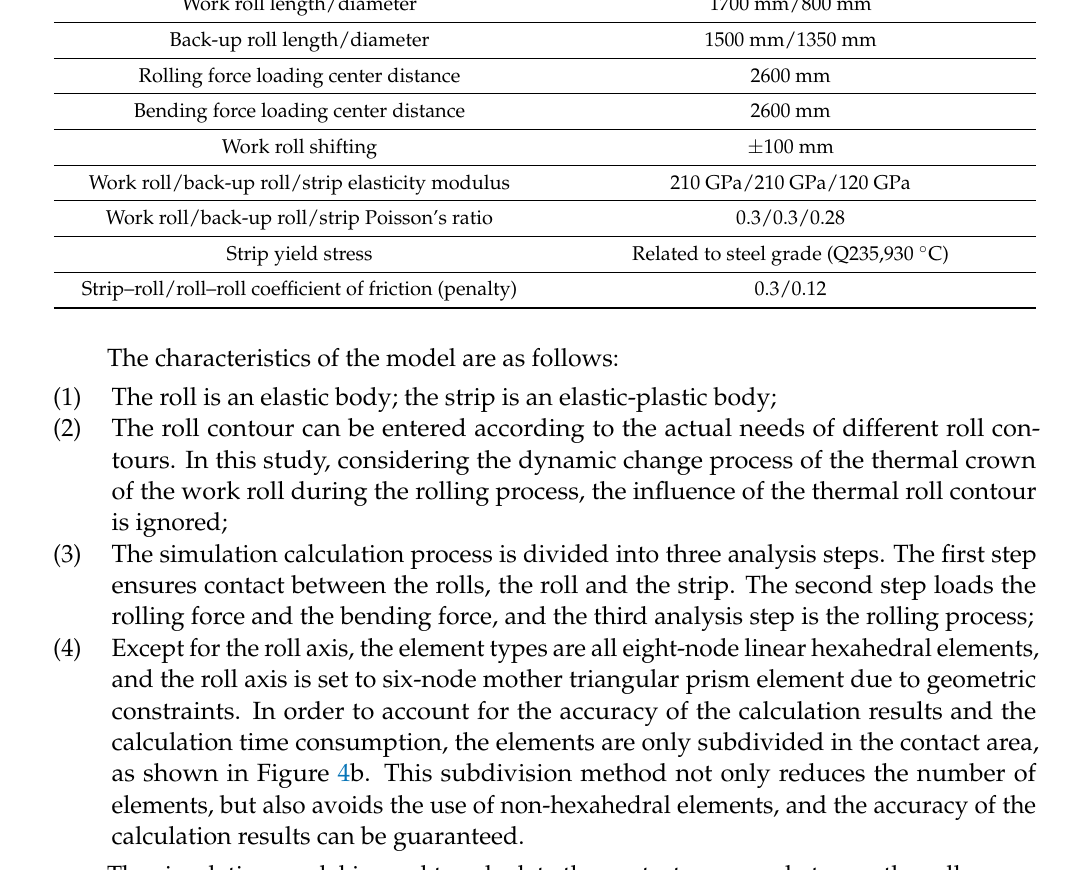
obtained to study the strip profile control characteristics.